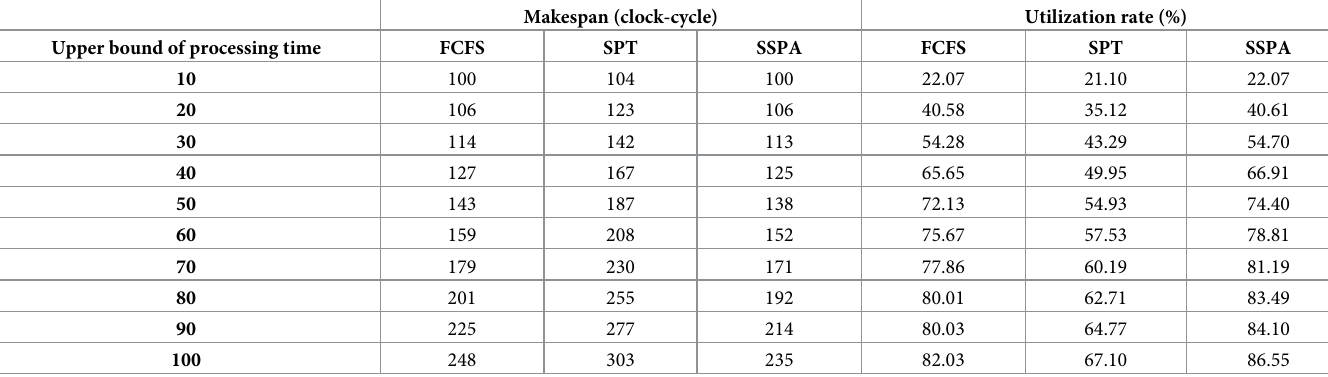
Makespan (clock-cycle) Utilization rate (%)